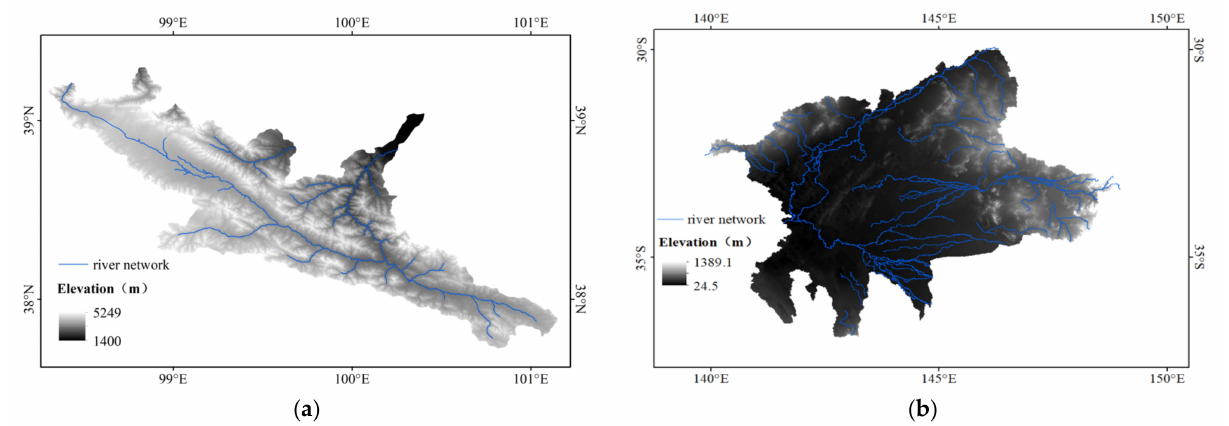
Figure 3. River networks extracted from DEM. ( a ) The Heihe River Basin; ( b ) The Murray Darling Basin. Table 2. The extraction results of gradient, sinuosity, and river width of each river section.